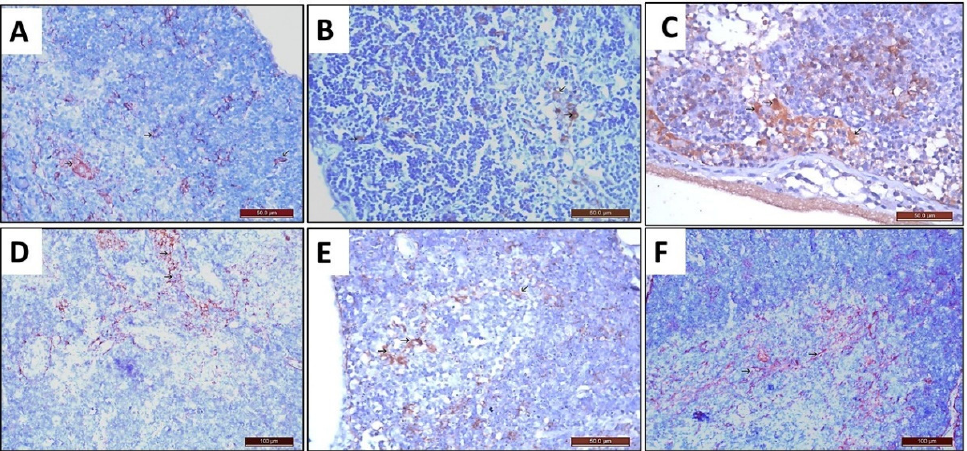
Figure 11. Photomicrographs of sections of the thymus stained with anticytokeratin ×400 from different groups. ( A ): (Control group) shows a positive brownish immunoreaction in some cells of the reticuloepithelial cells ( → ) in the cortex and medulla. ( B ): (OLE group) is similar to control group. ( C ): (Cis group) shows an obvious increase in the positive brownish immunoreaction in some cells of the reticuloepithelial cells ( → ) in the cortex and medulla. ( D ): (Cis + OLE group) shows a decrease in the positive brownish immunoreaction in the reticuloepithelial cells ( → ) in the cortex and medulla. ( E ): (Cis + CM-MSC group) shows a decrease in the positive brownish immunoreaction in the reticuloepithelial cells ( → ) in the cortex and medulla. ( F ): (Cis + MSCs group) shows an obvious decrease in the positive brownish immunoreaction in the reticuloepithelial cells ( → ) in the cortex and medulla. Table 7. The mean and standard deviation (SD) of the optical density of anticytokeratin immunore- action activity in the reticuloepithelial cells of the thymus in the different experimental groups.